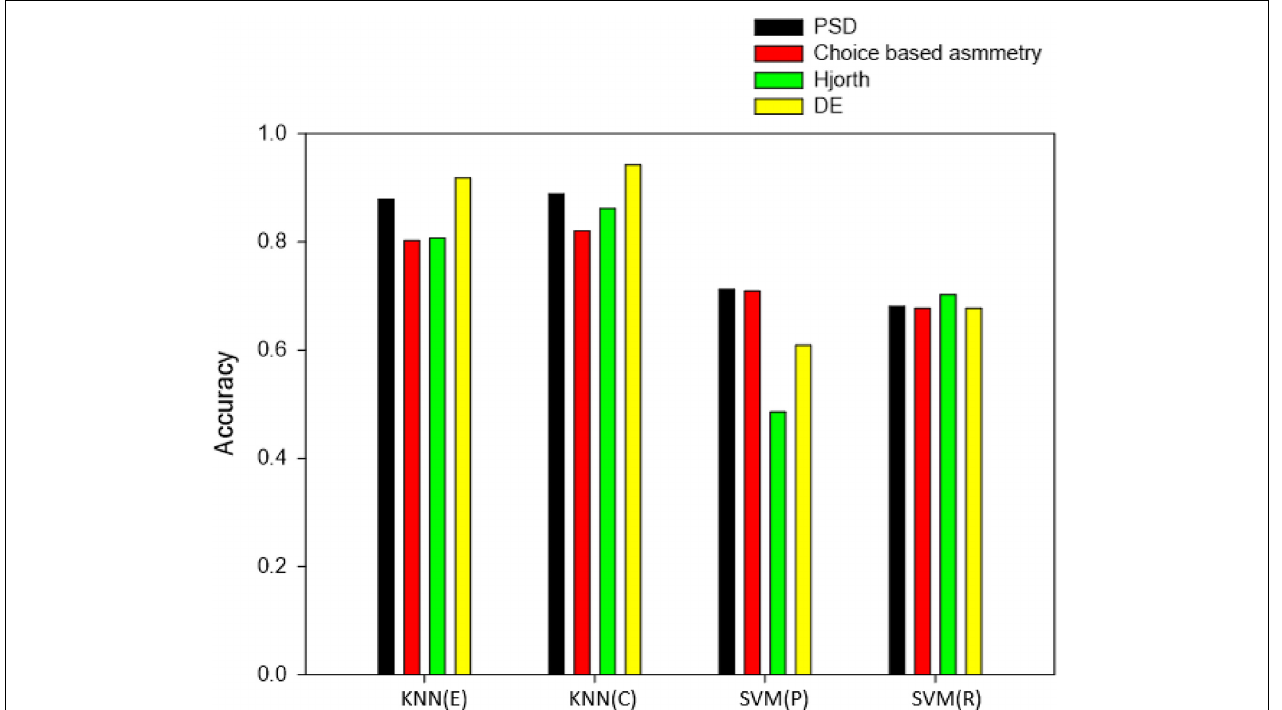
FIGURE 7 | Classification accuracy of four classifiers based on different feature sets.